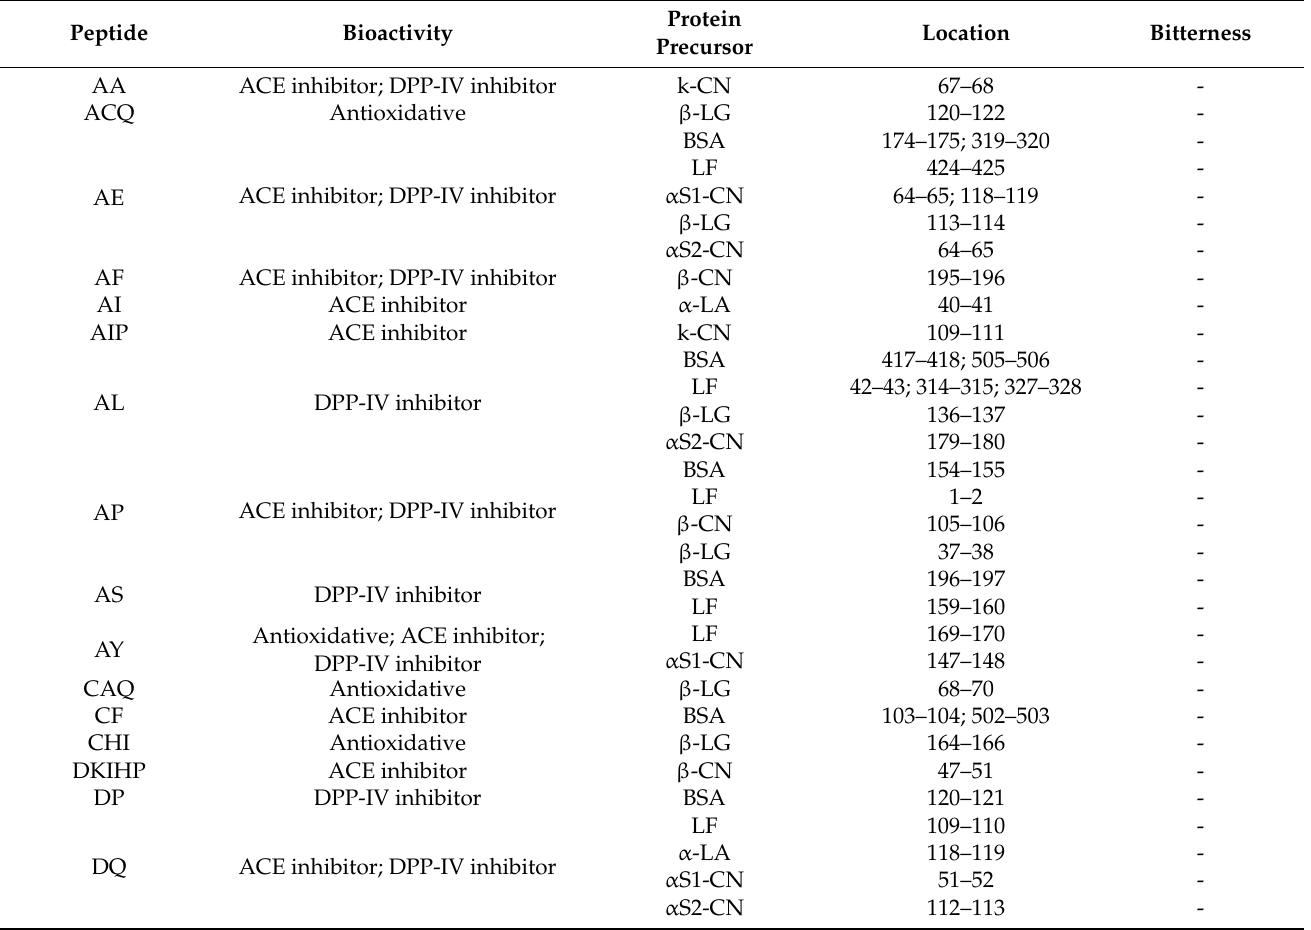
Table 5. Mapping of bioactive peptides in products of hydrolysis (in silico) of milk whey